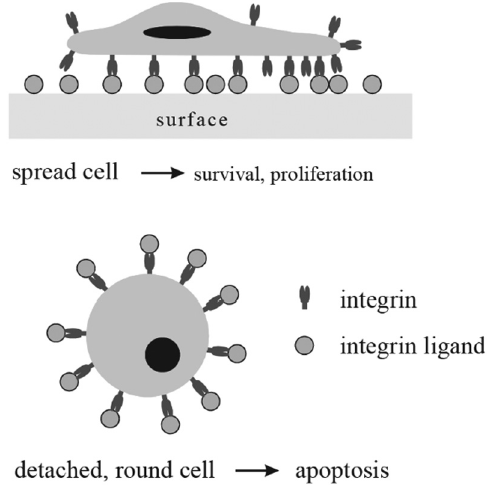
Figure 5: Surface modi fi ed by immobilized ligands which act as agonists of the ECM. Cells cannot adhere to the substrate with nonimmobilized ligands leading to apoptosis ( reproduced from ref. [ 62 ])